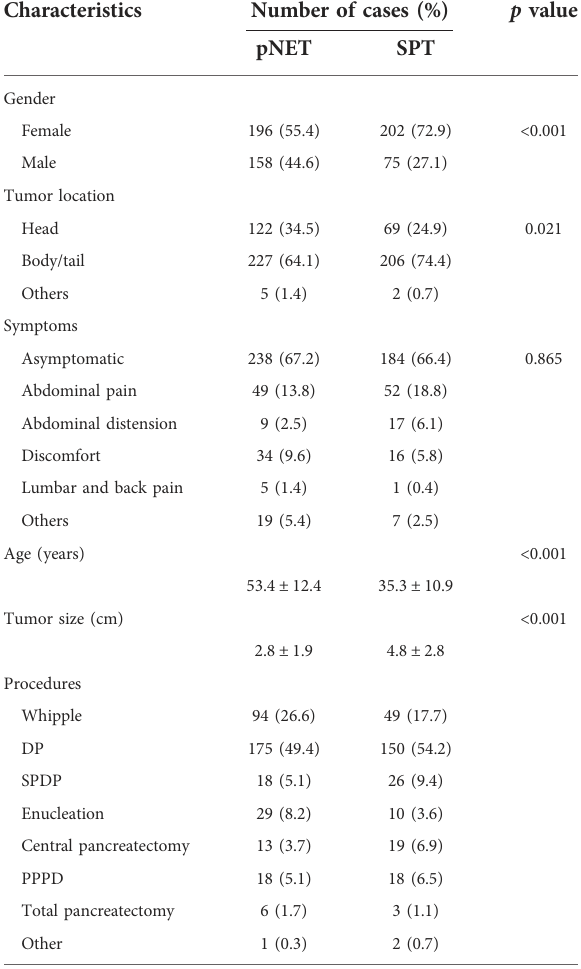
TABLE 1 Demographic data of pNET and SPT cases. Characteristics